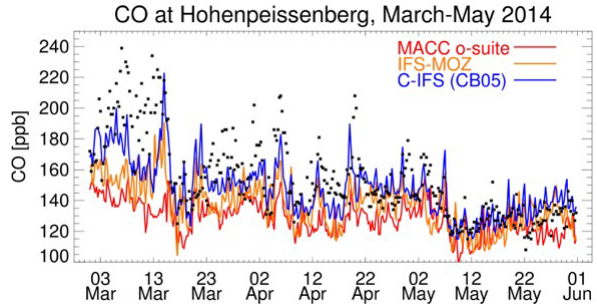
Figure 6. O-suite (red), stand-alone IFS–MOZART (orange) and C-IFS (CB05) (blue) compared to GAW observations (black dots) at Hohenpeissenberg station (47.80 ◦ N, 11.02 ◦ E) for the period March–May 2014. The correlation coefficients are 0.59, 0.62 and 0.71 for the o-suite, IFS–MOZART and C-IFS (CB05),